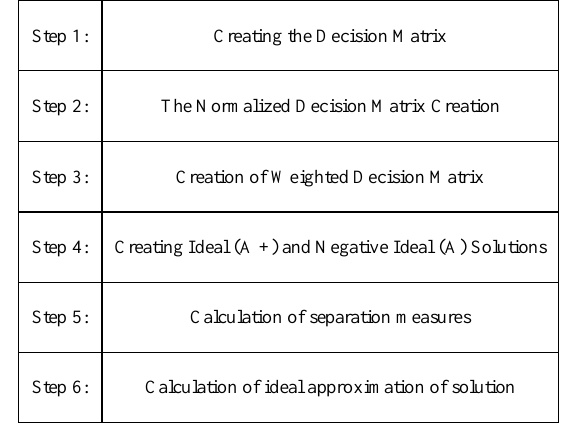
Table 4: TOPSIS Analysis Application